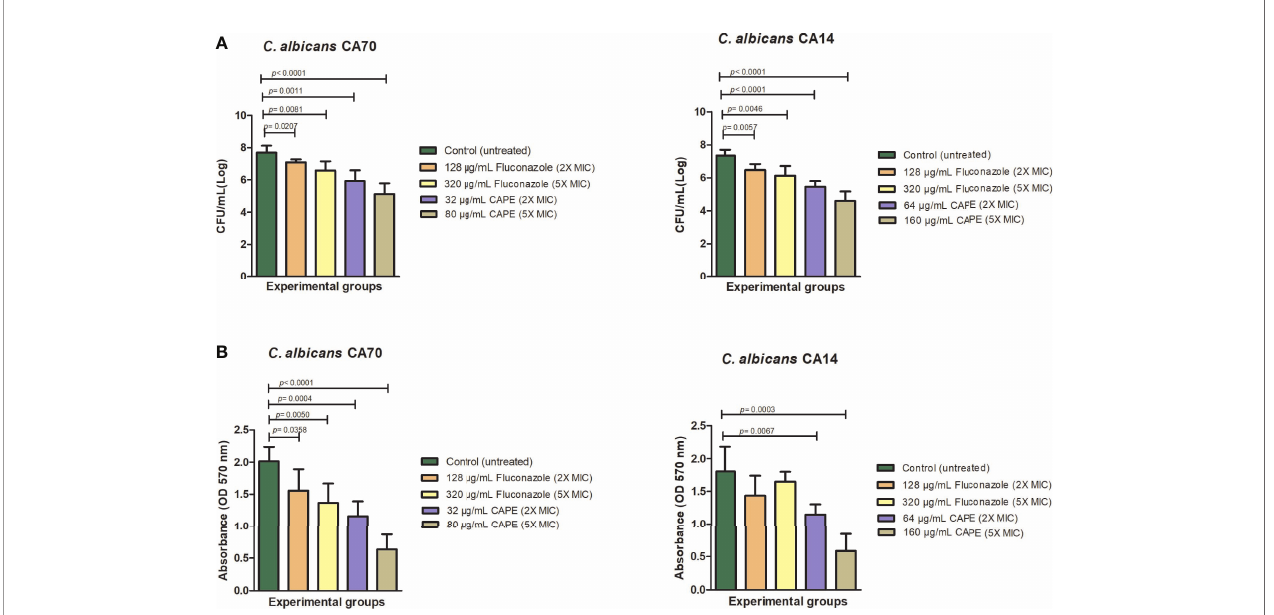
FIGURE 1 | Analysis of in vitro C. albicans bio fi lms. Mature bio fi lms (48 h) formed in 96-wells plates for clinical strains of fl uconazole-resistant C. albicans were treated with different concentrations of fl uconazole and CAPE (2 x MIC and 5 x MIC). (A) The viable C. albicans cells number are shown in CFU per milliliter count. (B) Bio fi lm biomass analysis expressed in optical density (570nm). The treatments were compared to the control group using Student ’ s t test ( p < 0.05).